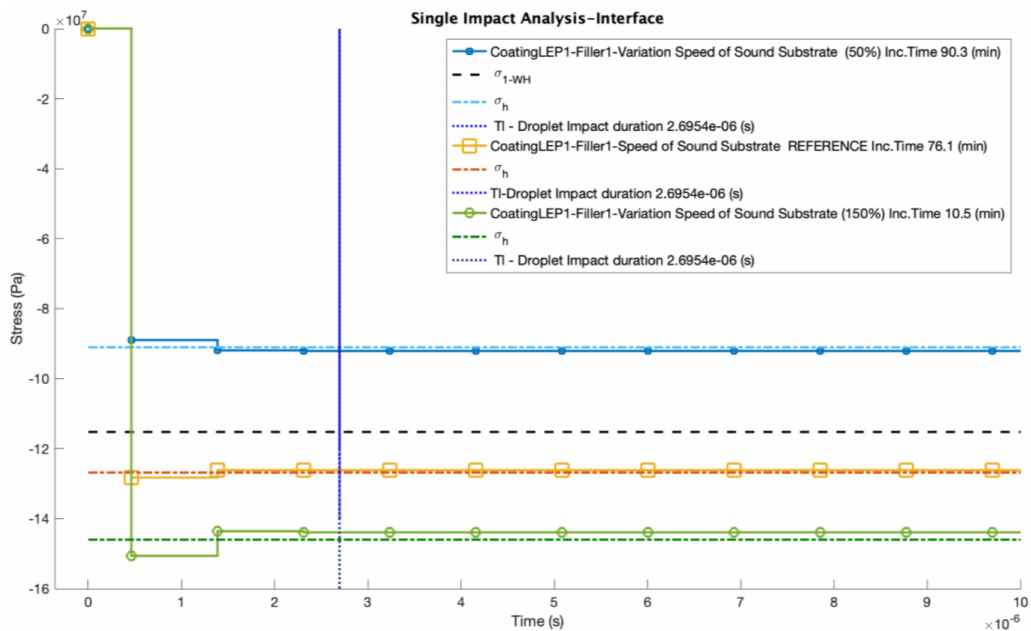
Figure 12. Interface stress evolution analysis for simulated material LEP prototype comparing 50% variation of Filler Substrate Speed of Sound.